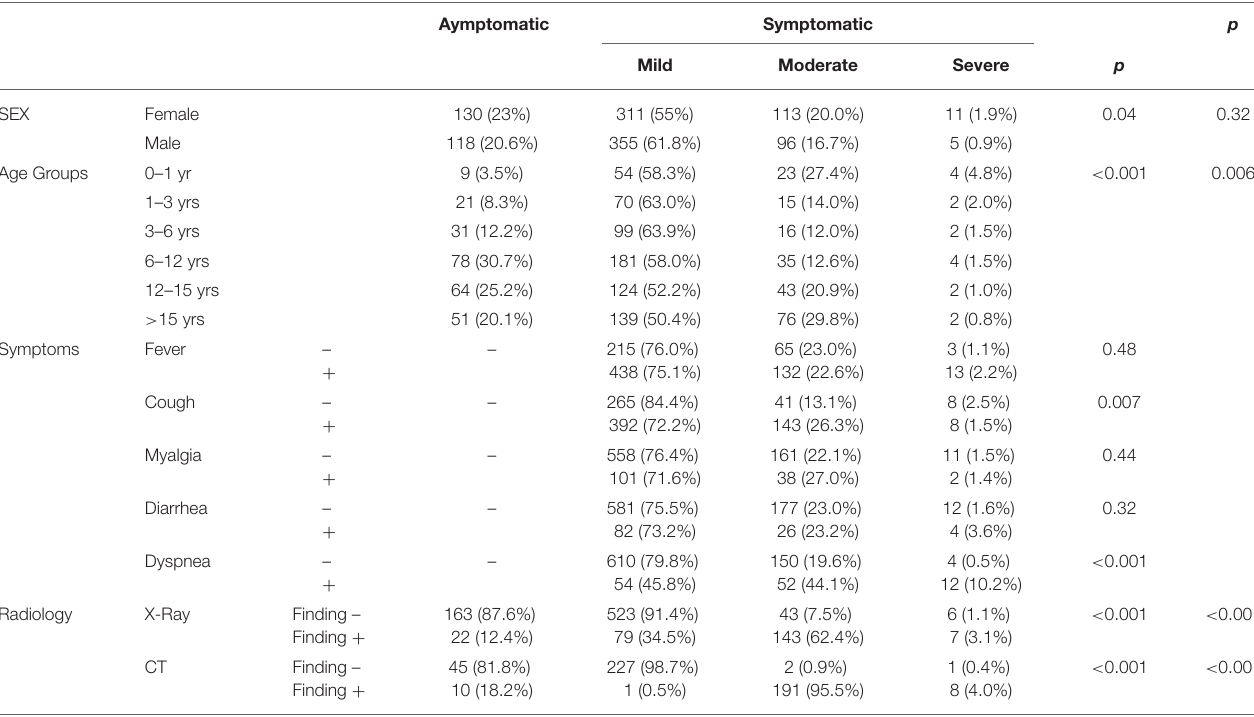
TABLE 5 | Comparison of groups due to